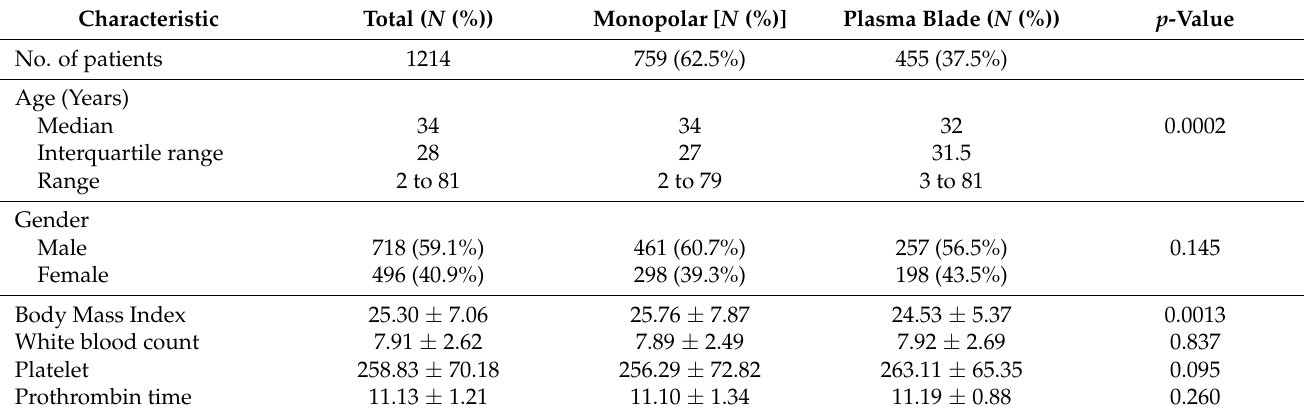
Table 1. Patient demographics.